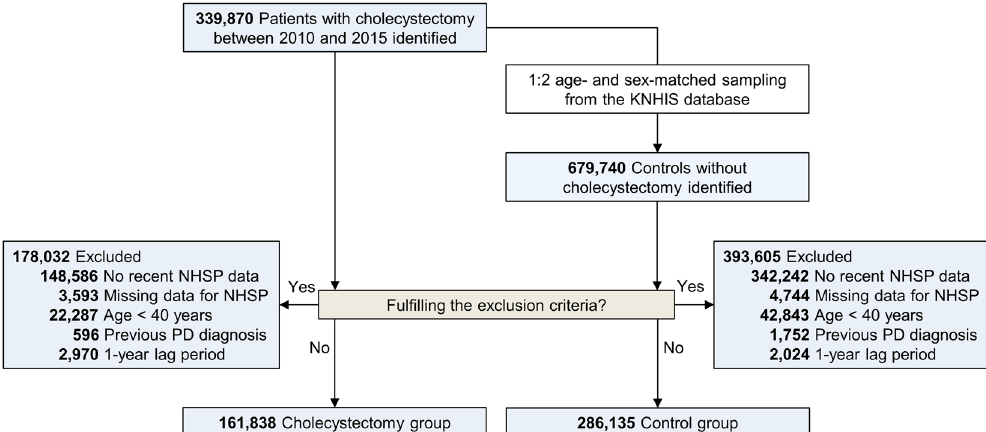
Fig. 1 Flow diagram of subject selection. Abbreviations: KNHIS Korean National Health Insurance Service, NHSP National Health Screening Program, PD Parkinson ’ s